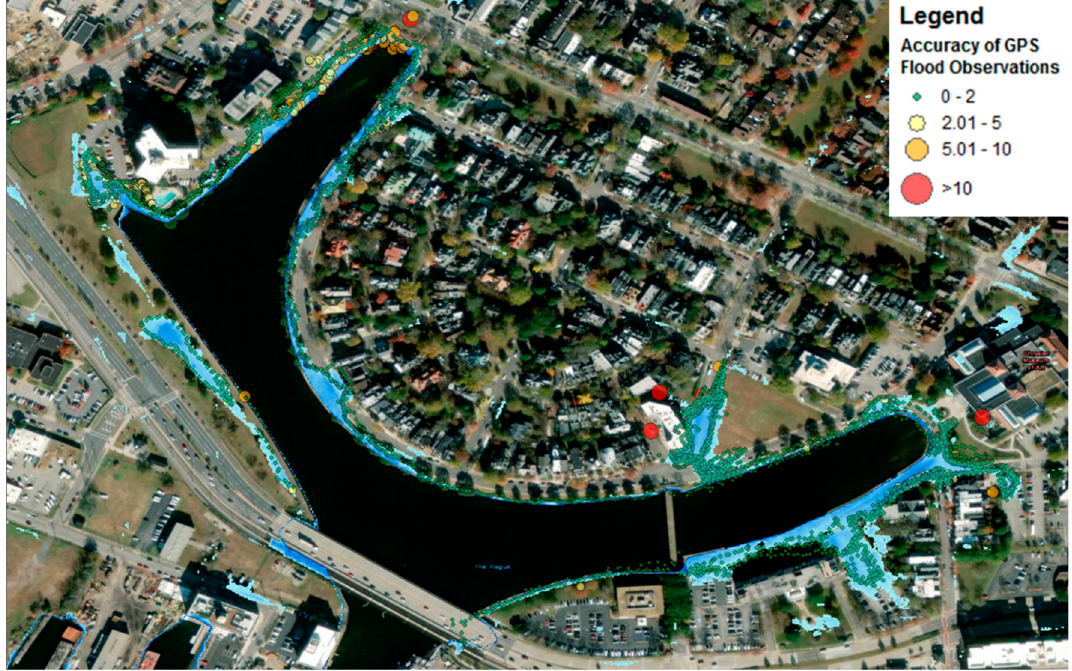
Figure 10. Map of radial positional accuracy (in meters) reported by the Sea Level Rise mobile app in Norfolk’s Hague during Catch the King 2017. Points in red were not included in the spatial comparison.